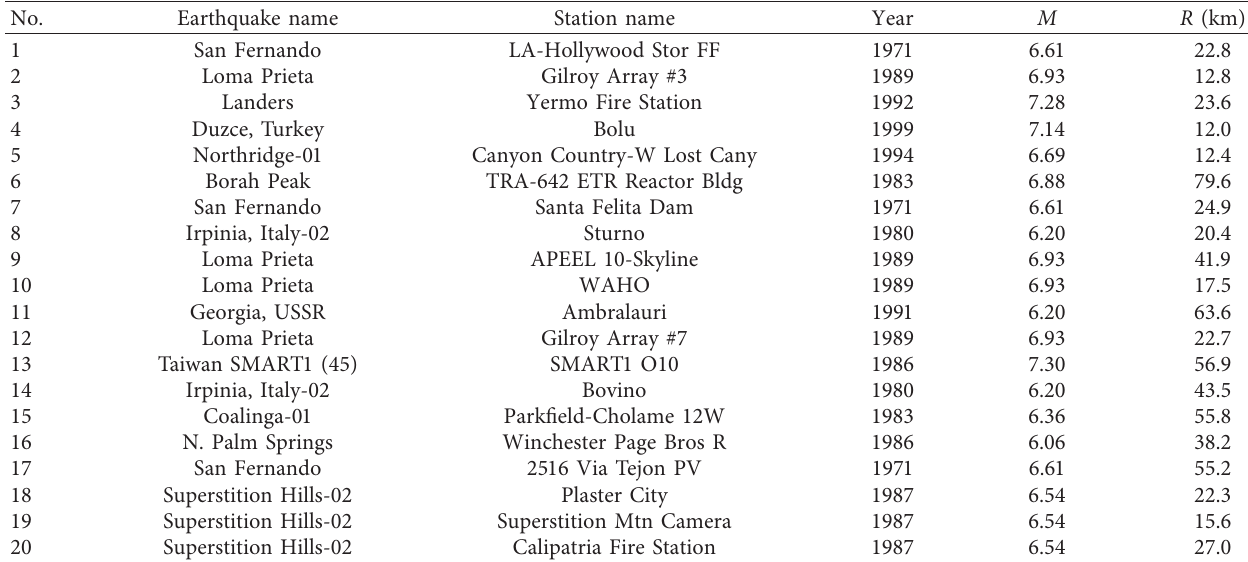
Table 4: The ground motion records used in this